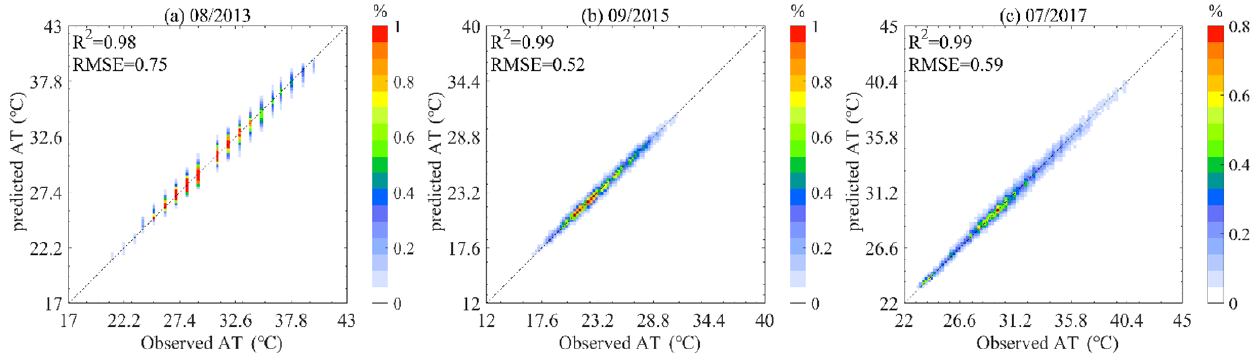
Figure 7. Scatterplot of predicted and observed air temperature using data in a 1-month 5-fold CV for the testing set on (a) August 2013, (b) September 2015, and (c) July